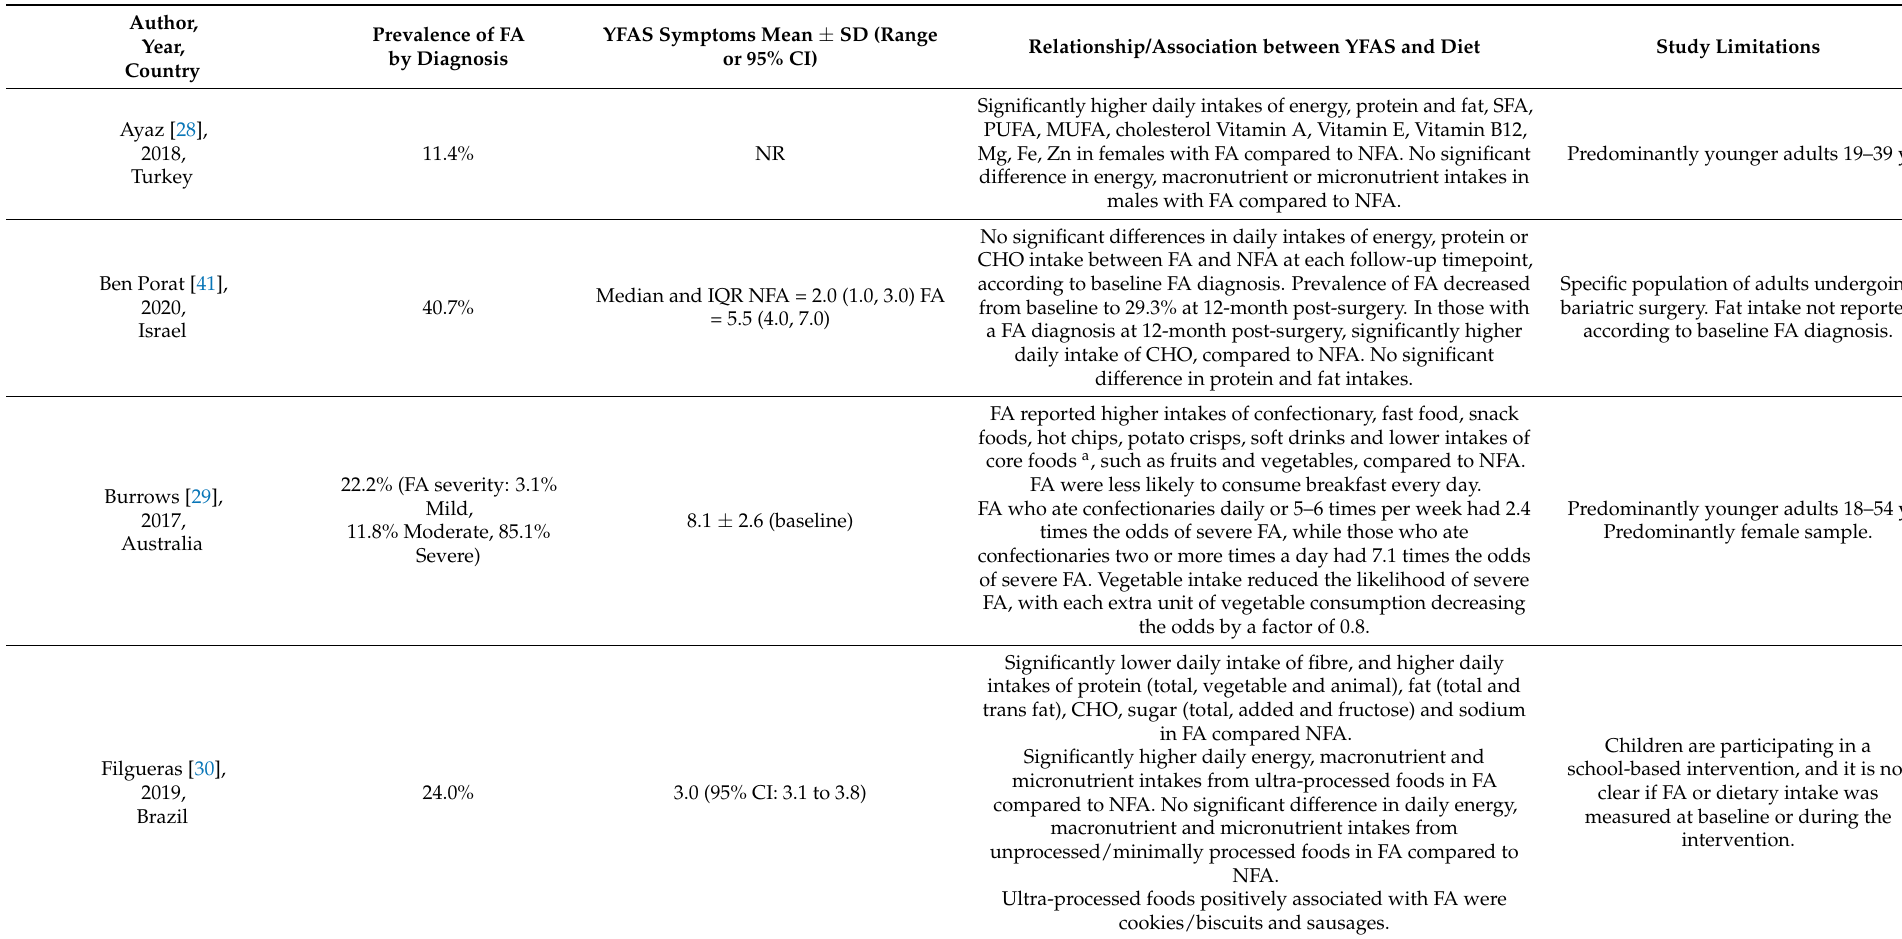
Table 3. Outcomes of included